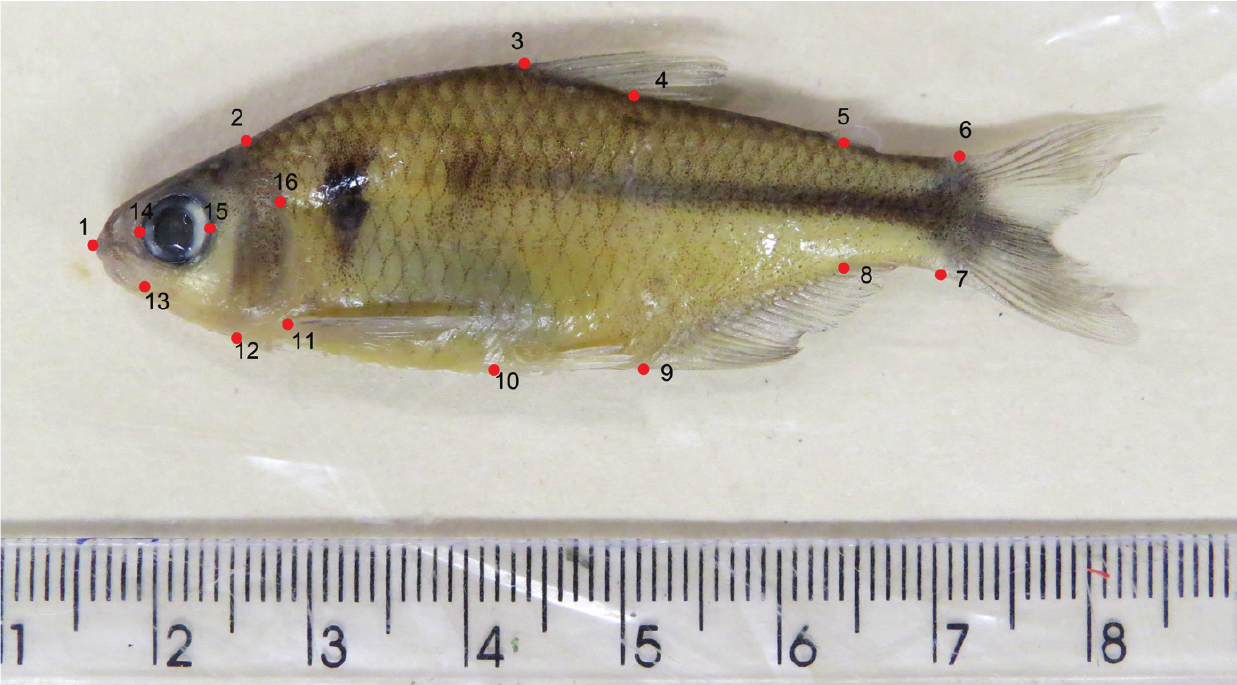
Fig. 2. Individual of Bryconamericus iheringii (UFRGS 21339) with the landmarks used for geometric morphometric. 1 = Tip of snout; 2 = Top of head (at the supraoccipital bone); 3 = Anterior insertion of dorsal fin; 4 = Posterior insertion of dorsal fin; 5 = Posterior insertion of adipose fin; 6 = Dorsal end of caudal peduncle; 7 = Ventral end of caudal peduncle; 8 = Posterior insertion of anal fin; 9 = Anterior insertion of anal fin; 10 = Origin of pelvic fin; 11 = Origin of pectoral fin; 12 = Ventral end of head; 13 = Tip of the upper jaw (maxillary bone) ; 14 = Anterior margin of eye; 15 = Posterior margin of eye; 16 = Anterior margin of